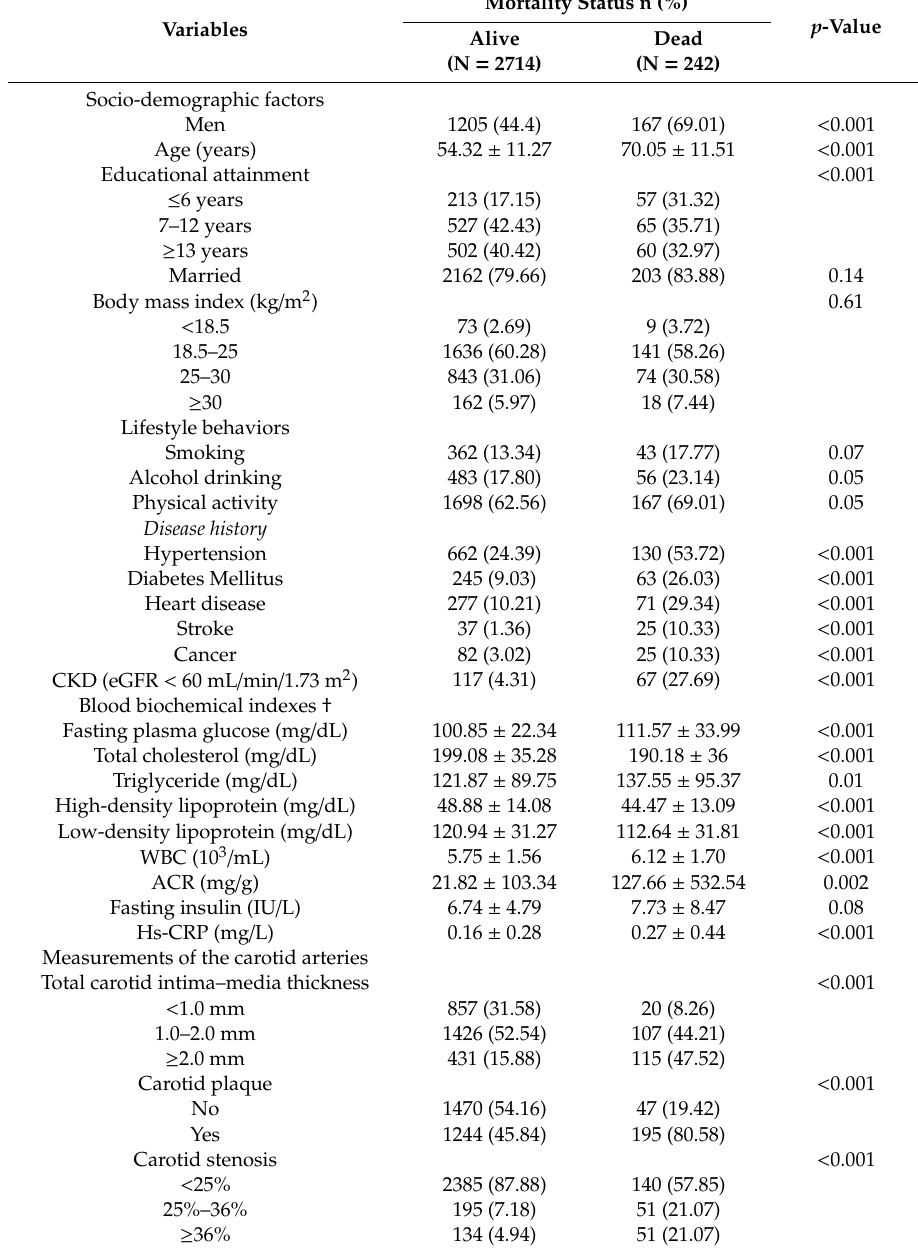
Table 1. The distributions of baseline socio-demographic factors, lifestyle behaviors, disease history, blood biochemical indexes according to mortality